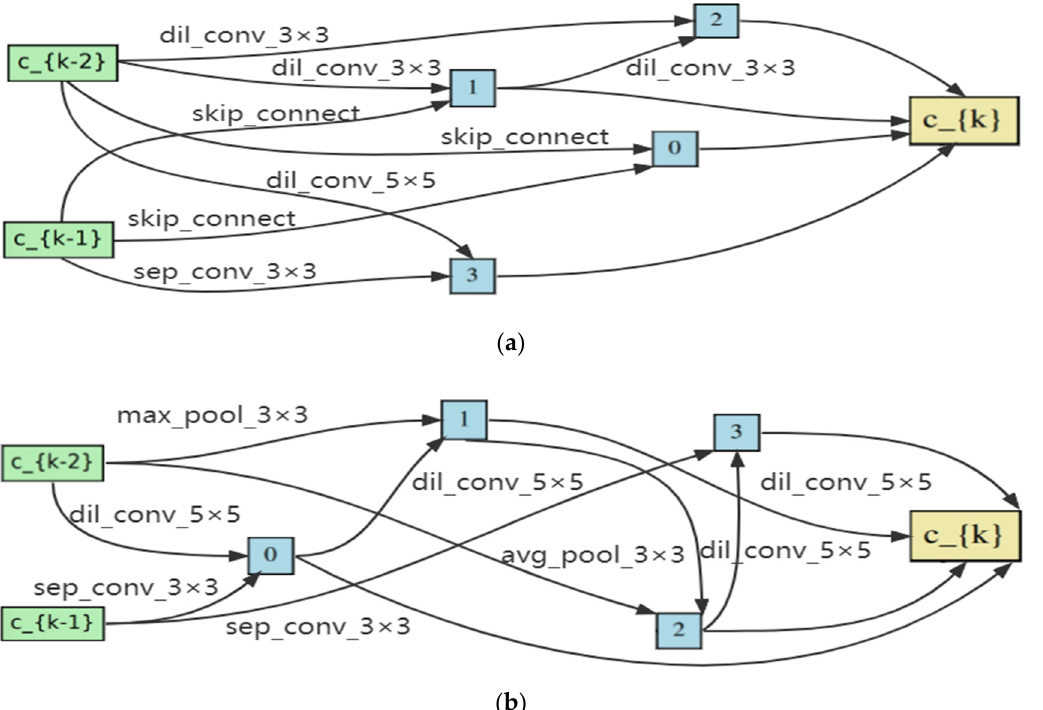
Figure 5. Searched cell architectures of GPAS [41]. ( a ) Normal cell searched by GPAS. ( b ) Reduction cell searched by GPAS.